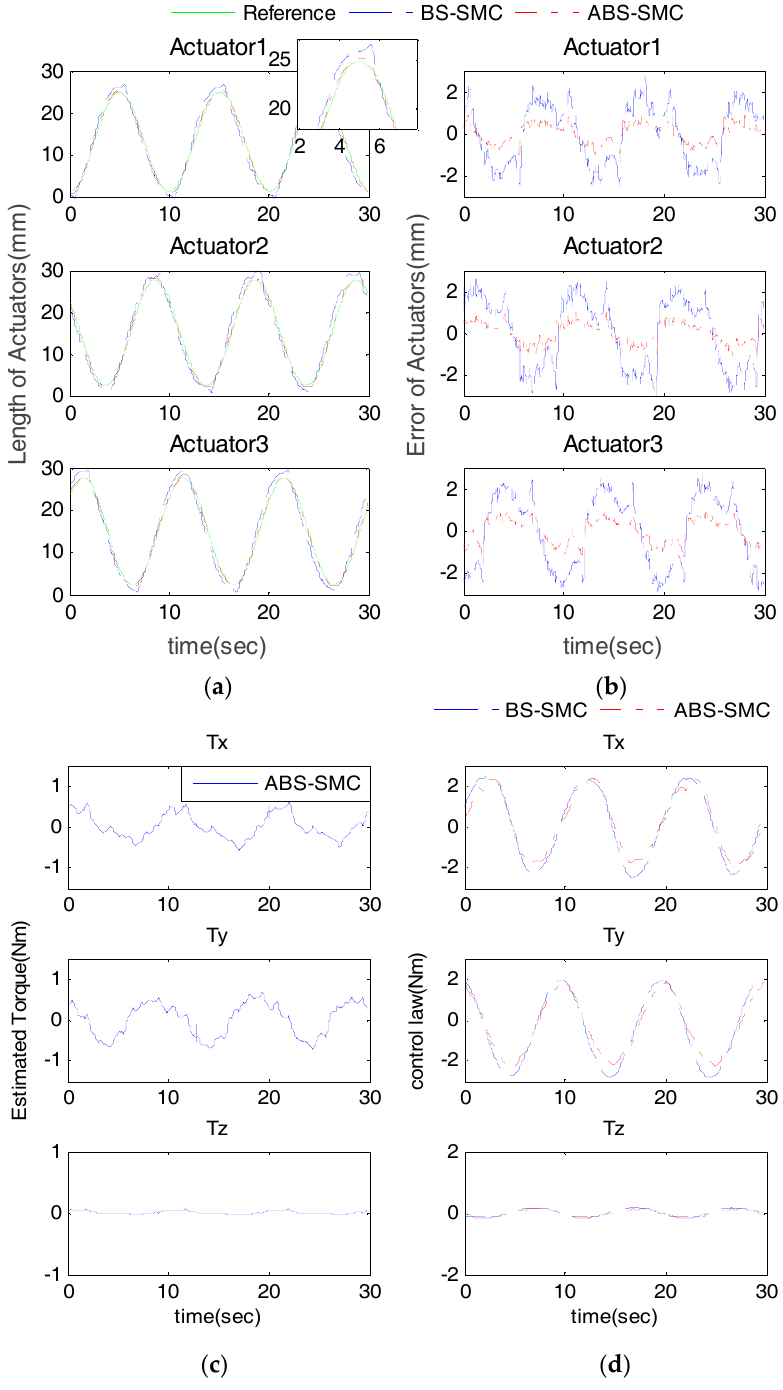
Figure 8. Actuator position tracking results with subject 1: ( a ) actuator position tracking results; ( b ) the actuator tracking errors; ( c ) the estimated external torque (using ABS-SMC) and ( d ) the control output tuning processing via ABS-SMC disturbance estimation.